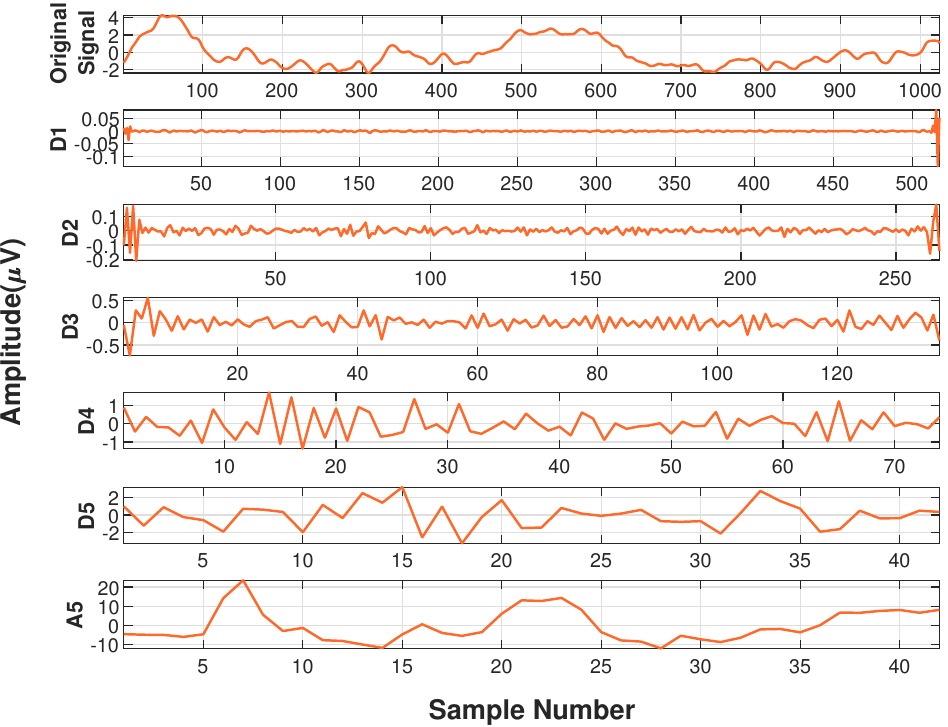
Figure 4. Subbands obtained after wavelet decomposition of a 2-second epoch of CAP Phase-A.